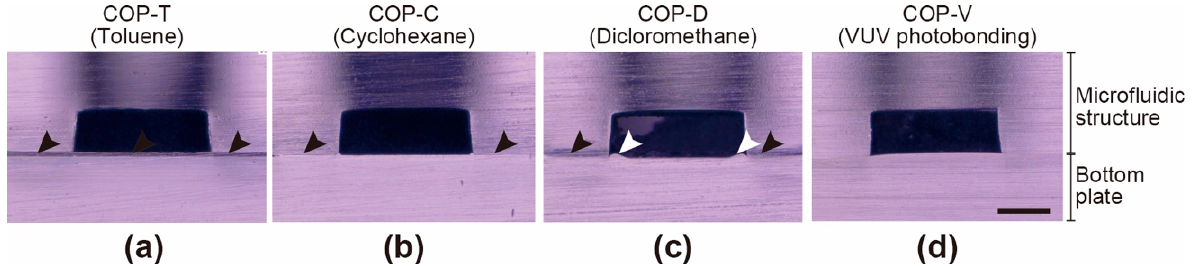
Figure 2. Cross-sections of microfluidic channels in cyclo-olefin polymer (COP)-based microfluidic devices. The devices were prepared by assembling a microfluidic structure and base plate by solvent bonding using ( a ) toluene (COP-T), ( b ) cyclohexane (COP-C), and ( c ) dichloromethane (COP-D); and ( d ) by a vacuum ultraviolet (VUV)-photobonding process without any solvent (COP-V). The white arrows indicate deformation of the microfluidic channel. The black arrows indicate the color change in the COP material at the bonding interface. Scale bar: 300 µm.